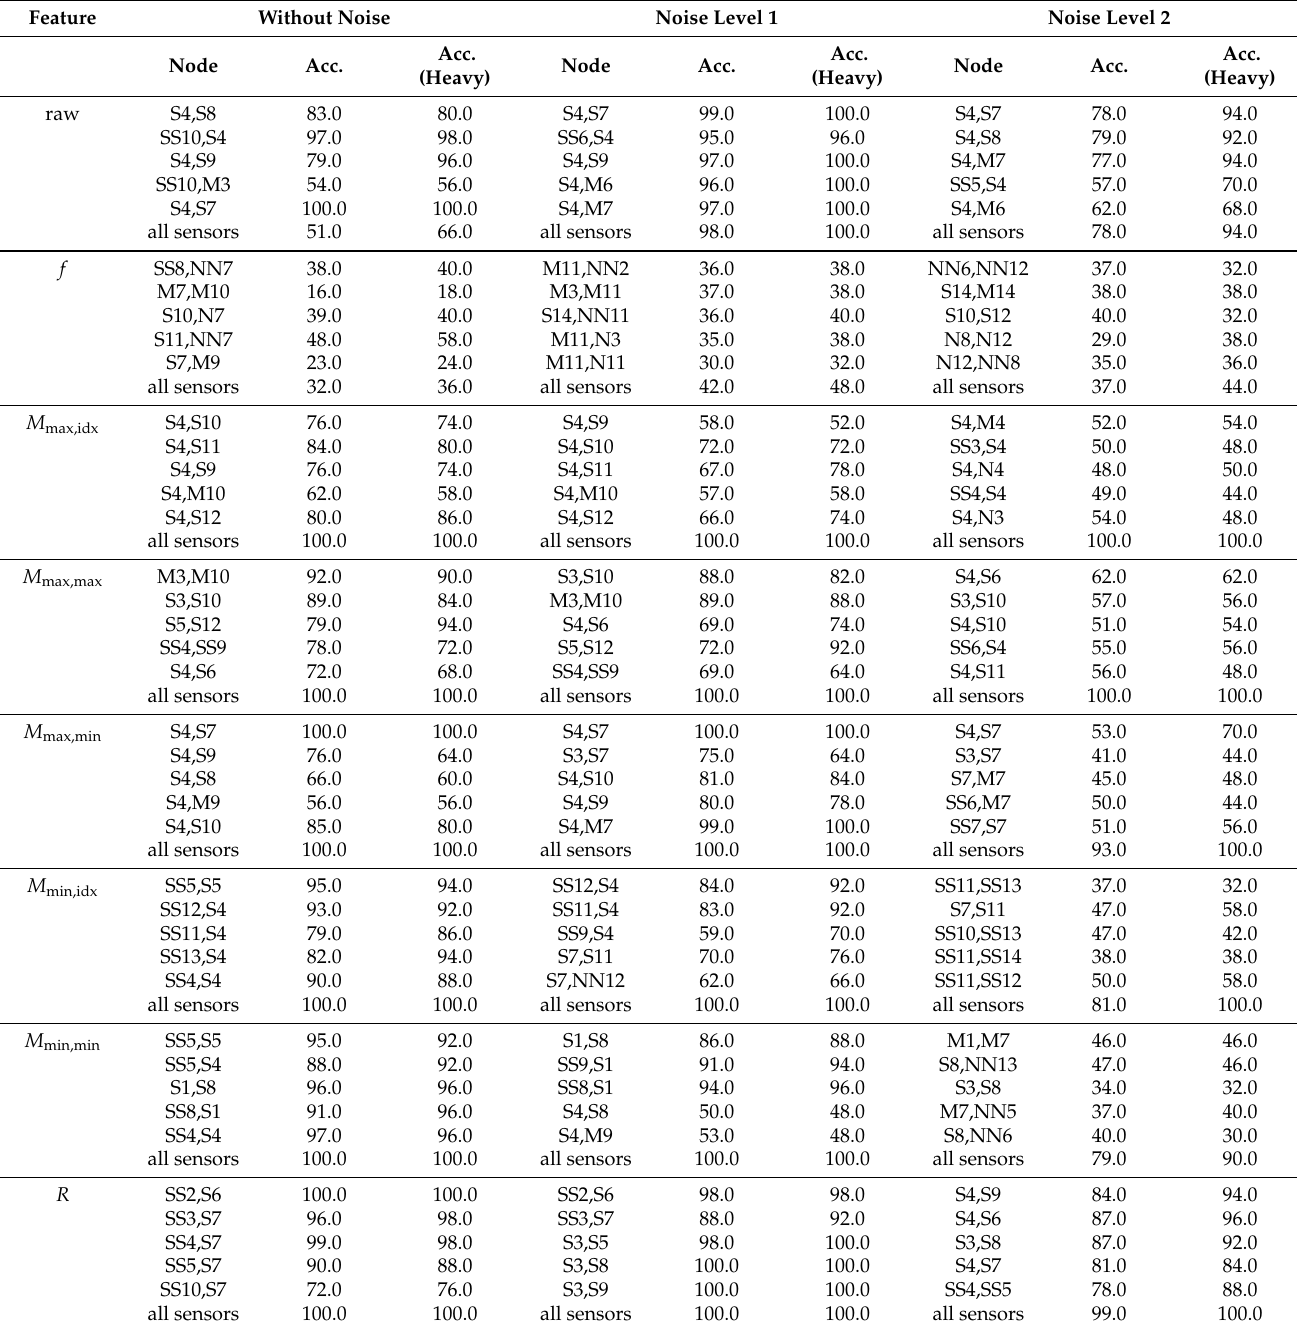
Table 5. Results on the temperature test dataset sorted by the best five sensor pairs of each feature from Table 3 based on strain in x direction. Crossings at different temperatures were used as the test dataset (not equal to 20°C). The table is structured like Table